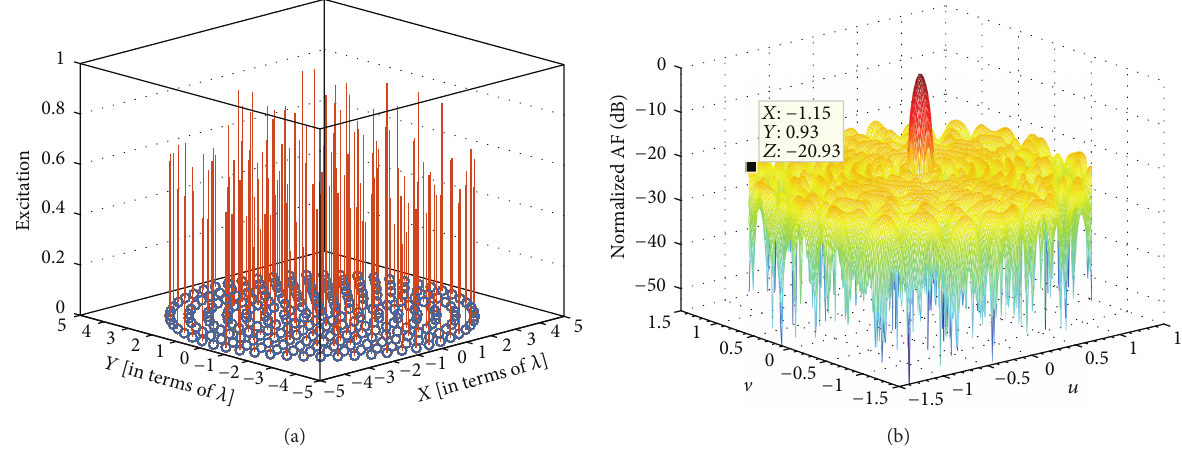
Figure 7: Nonuniform CCAA optimized by MTLBO for SLL reduction in basically extended space. (a) Configuration and excitation of a 152-element nonuniform array and (b) the related array factor with SLL = − 20.93 dB and FNBW = 0.13.